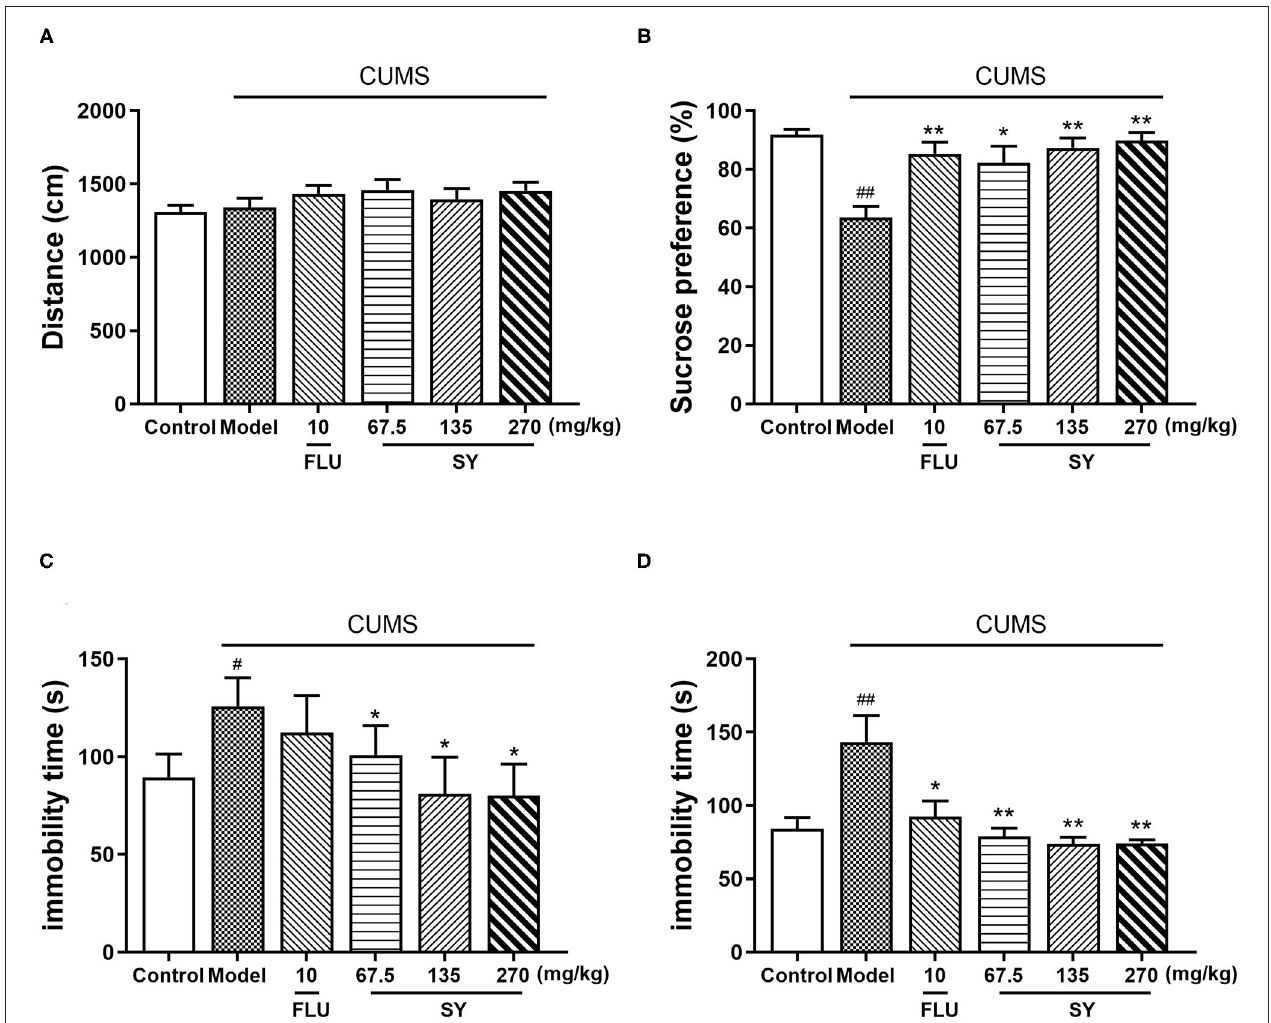
FIGURE 3 | Antidepressant-like effects of chronic SY treatment on CUMS rats. (A) Open field test. (B) Sucrose preference test. (C) Tail suspension test. (D) Forced swim test. Data represent the mean ± S.E.M. ( n = 10 per group). # p < 0.05, ## p < 0.01, vs. the control group; * p < 0.05, ** p < 0.01 vs. the CUMS group.